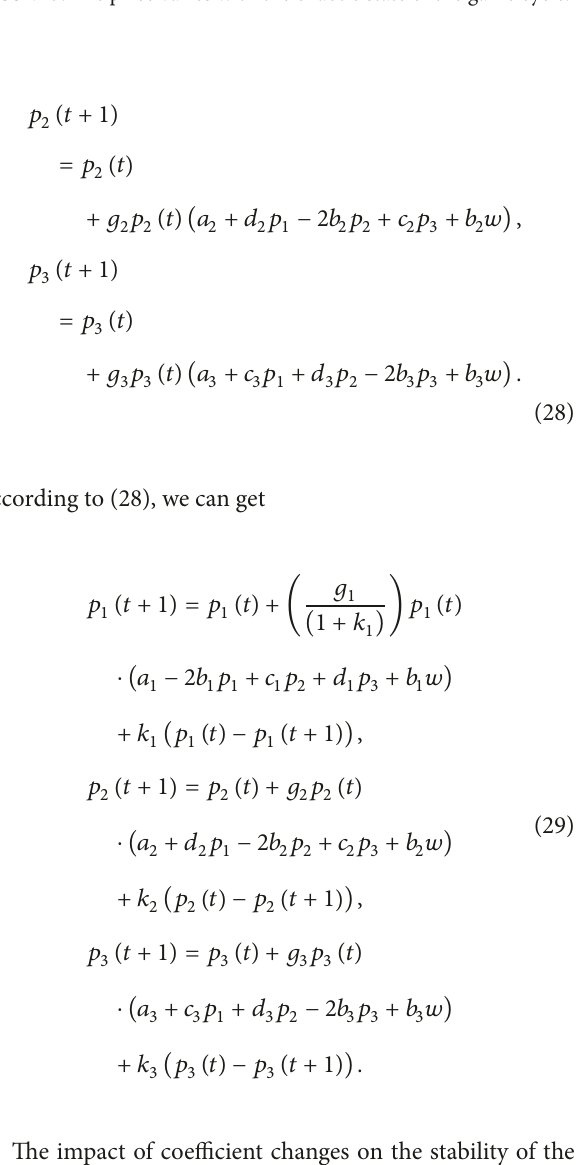
Figure 5: The price varies with the chaotic state of the game